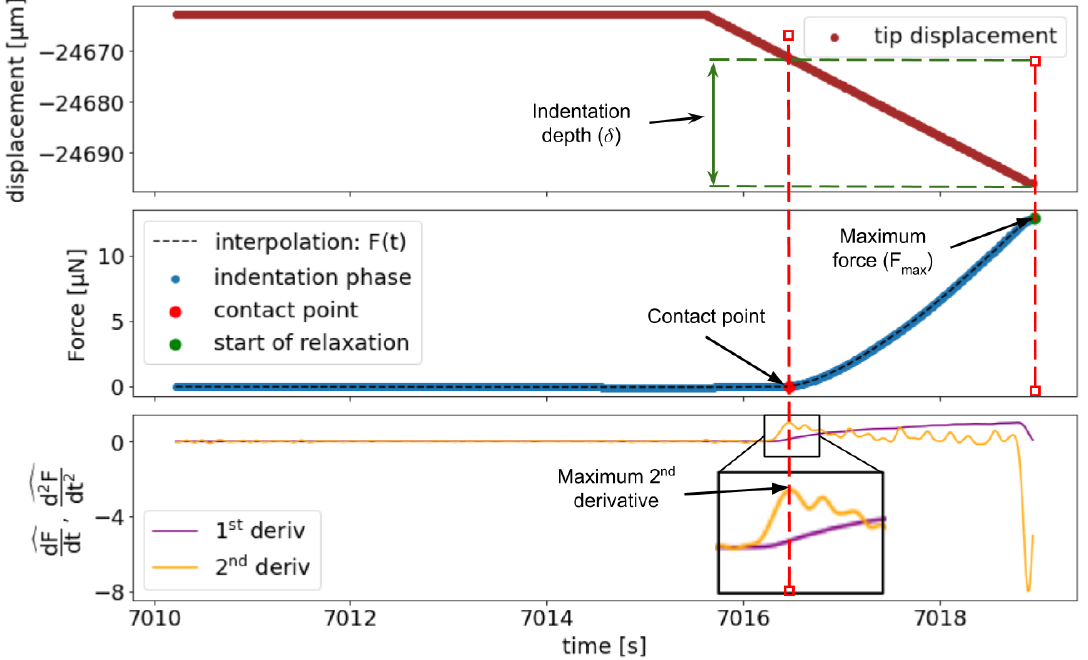
Figure A1. Example of the determination of the contact point, start of relaxation (maximum force) and indentation depth for a relaxation test performed on a 4 kPa PAM hydrogel immersed in ddH2O + 0.1% extran. The first and second derivatives of the force are calculated as a function of time. The superior graph shows the displacement of the probe tip as a function of time. The middle graph shows the time behavior of the measured force. The 1st and 2nd derivatives are calculated from this graph and shown in the inferior graph. Experimental data were interpolated and it was considered that the maximum of the 2nd derivative implied a concavity change associated with the change in force behavior (a linear behavior for the attractive forces domain and a F 2/3 for indentation forces domain) Thus the position, representative of the contact point is thus precisely determined by the maximum of the second derivative. Here, raw data are shown and time is therefore equivalent to displacement.